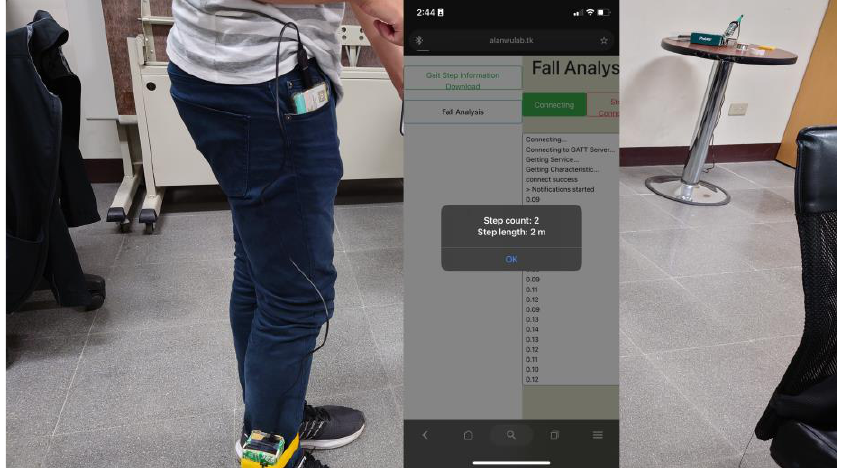
Figure 7. Step count detection of CPGAFDWD in iOS.